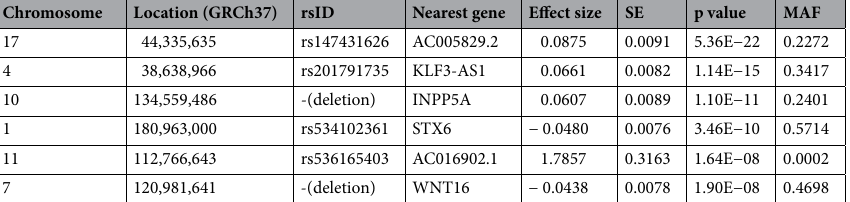
Table 2. Significant loci associated with delta age (p value < 5E-08). Single-variant test, SAIGE, was applied to array-genotyped and imputed genetics data.